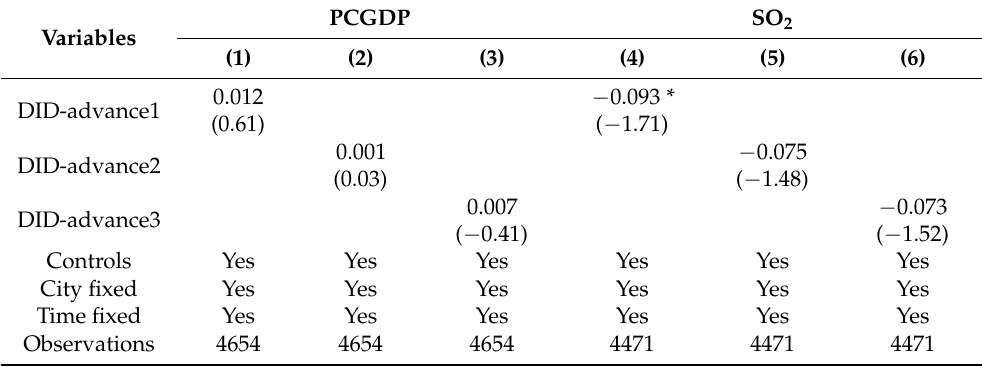
Table 3. Counterfactual test results.